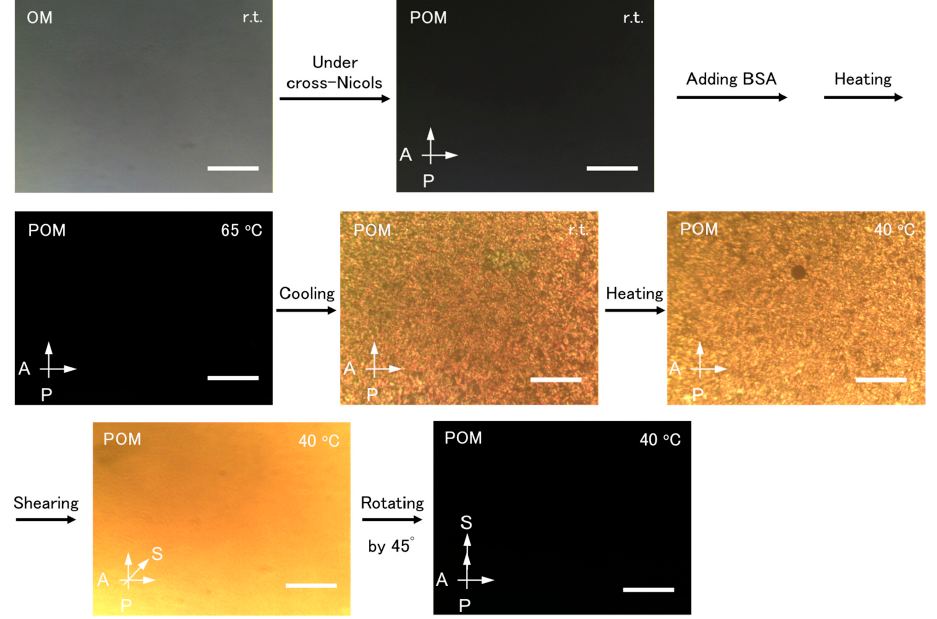
Figure 2. Photomicrographs of the optical microscopic (OM) and the polarized optical microscopic (POM) observations, the RP N L 1, and the RP N L 1·BSA. A, P, and S indicate the analyzer, polarizer, and shearing direction, respectively. Crystals 2018 , 8 , x FOR PEER REVIEW